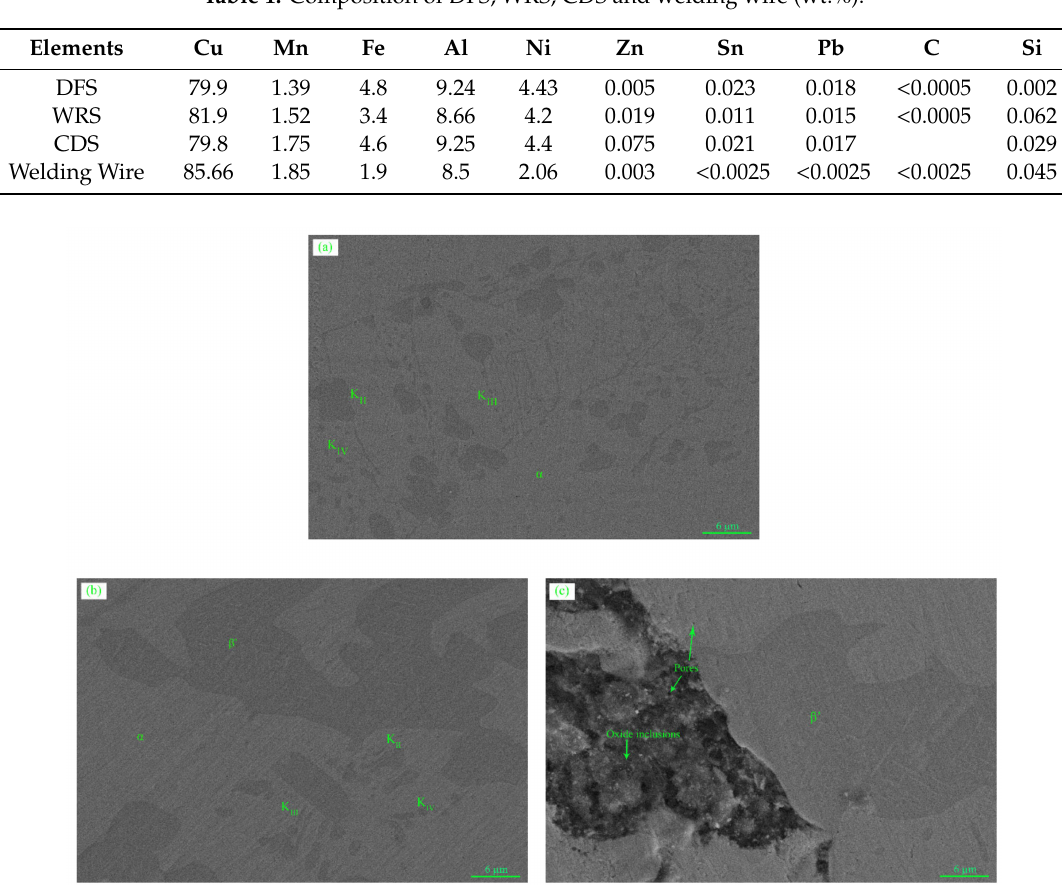
Figure 2. The microstructures before the corrosion of ( a ) DFS, ( b ) WRS and ( c ) CDS.